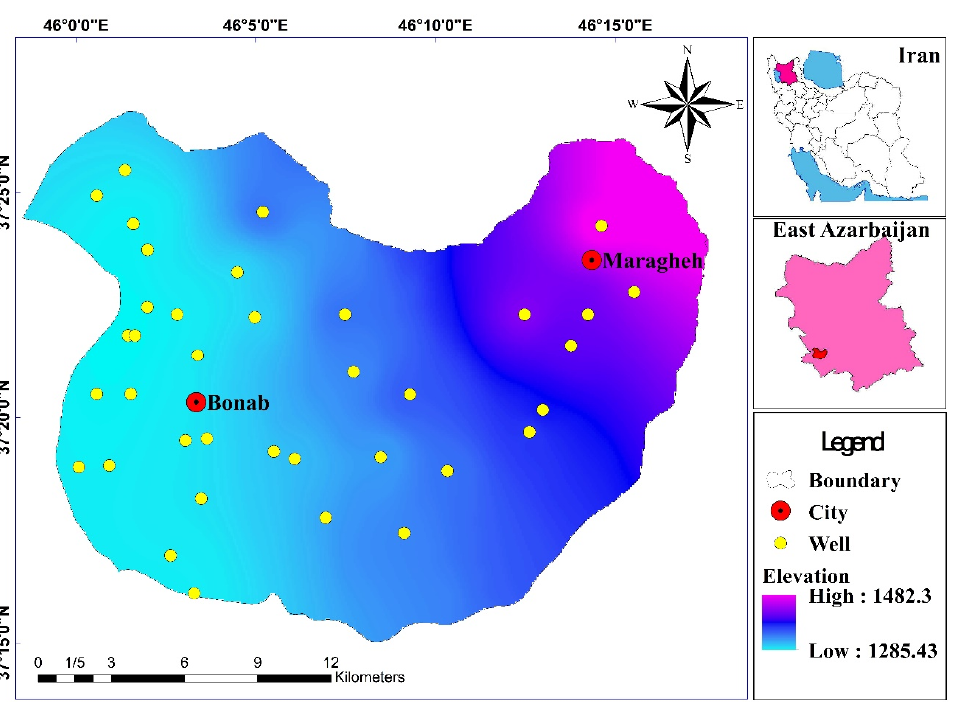
5 Figure 3. Average groundwater level (GWL) fluctuations in the Maragheh plain during 1996–2018. 2.4. Training and Testing of GWL Prediction Models The ANFIS and Wavelet-ANFIS models were trained based on monthly-observed GWL as well as precipitation (P) data time series. The following input-output prediction model for GWL at time t as a function of GWL t −1 and P t − j was applied: (cid:1833)(cid:1849)(cid:1838) (cid:3047) = (cid:1858)(cid:3435)(cid:1833)(cid:1849)(cid:1838) (cid:3047)(cid:2879)(cid:3036) , (cid:1842) (cid:3047)(cid:2879)(cid:3037) (cid:3439) (cid:1858)(cid:1867)(cid:1870) (cid:1861) = 1,2, … , (cid:1866) & (cid:1862) = 0,1,2, … , (cid:1866)